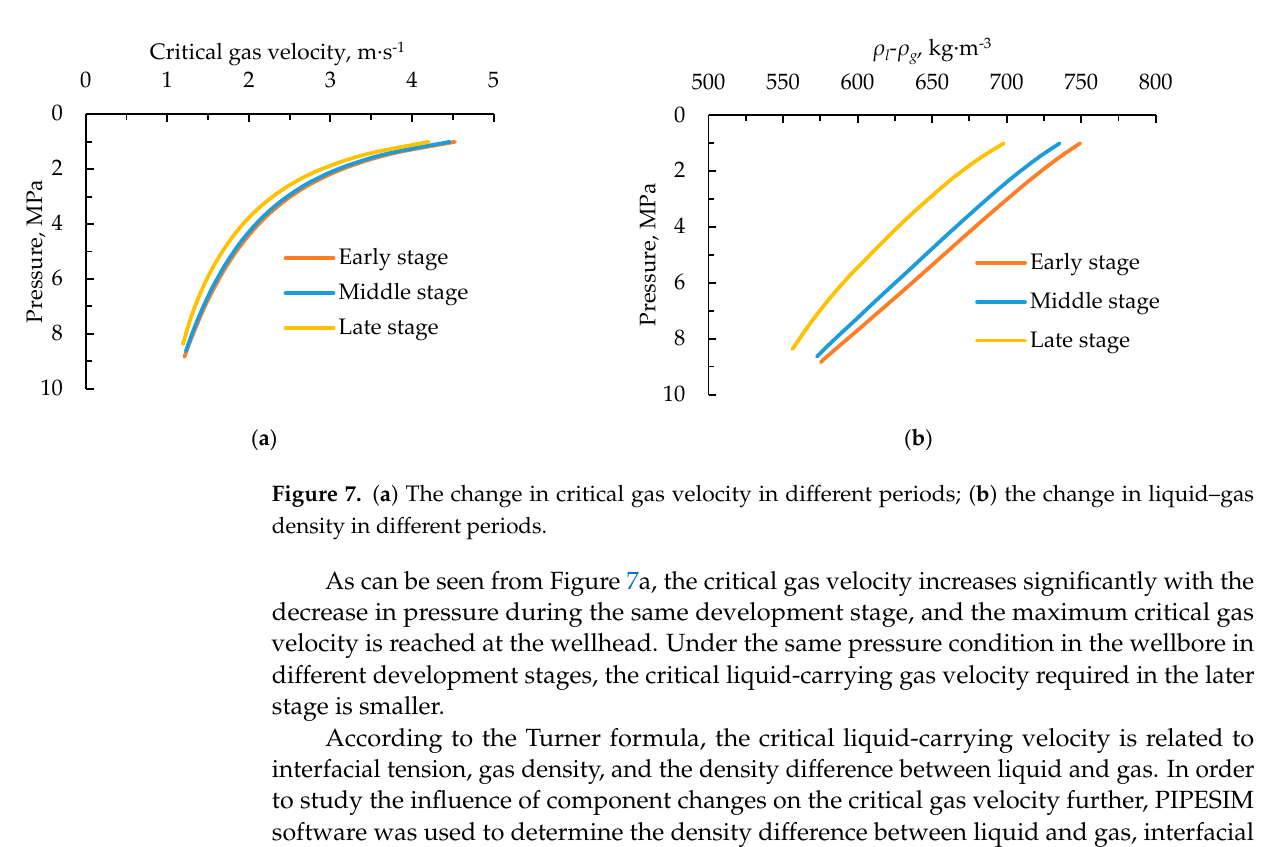
Figure 8. ( a ) The change in interfacial tension in different periods; ( b ) the change in gas density in different periods.